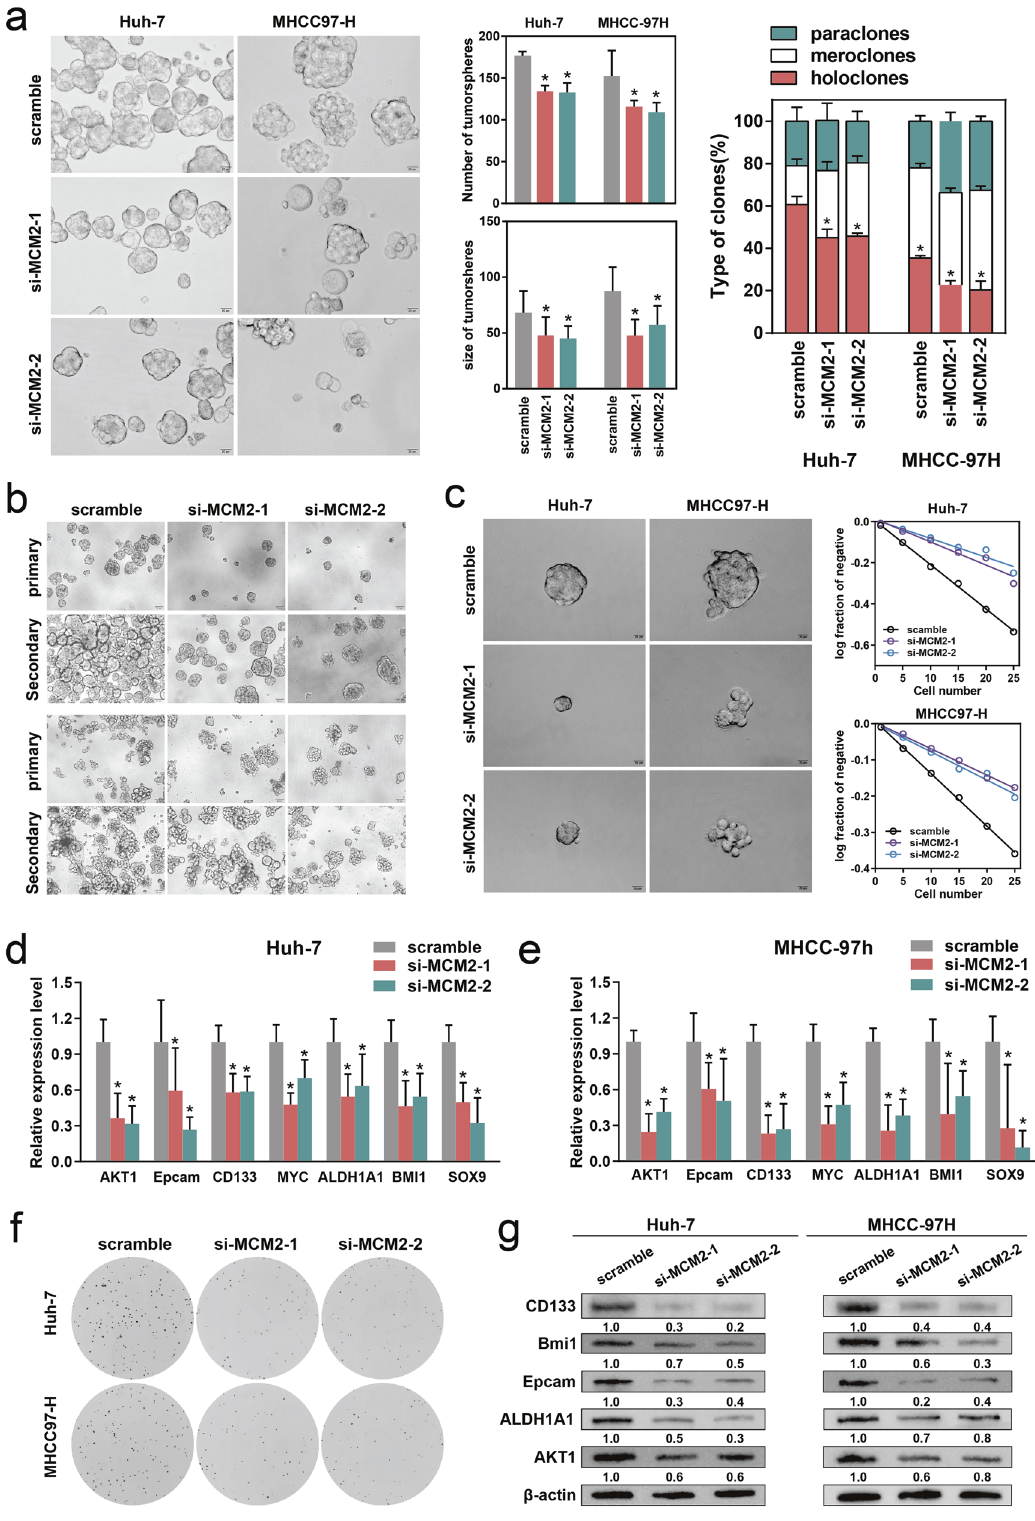
Fig. 2 Downregulation of MCM2 weakened the stemness of HCC cells. a Representative images of tumor-spheres in the si-MCM2 and scramble groups of the indicated cells, corresponding histogram and corresponding sphere morphology percentage chart; b Representative images of primary and secondary spheres formation in the si-MCM2 and scramble groups of the indicated cells, with corresponding histogram displayed in Fig S2d; c Representative images of tumor-spheres formation in the limiting dilution assays of the indicated cells and the log-dose slope of the si-MCM2 and scramble groups. d, e Expression of HCC stem biomarkers, including AKT1, Epcam, CD133, MYC, ALDH1A1, BMI1 and SOX9, in the si-MCM2 and scramble groups of the indicated cells. f Representative images of colony in the si-MCM2 and scramble groups of the indicated cells, with corresponding histogram displayed in Fig. S2e. g The immunoblotting for Bmi1, AKT1, CD133, ALDH1A1 and Epcam expression in the si-MCM2 and scramble groups of the indicated cells, determined by Western Blot assay; Data are shown as the mean ± SD from independent experiments. * P <